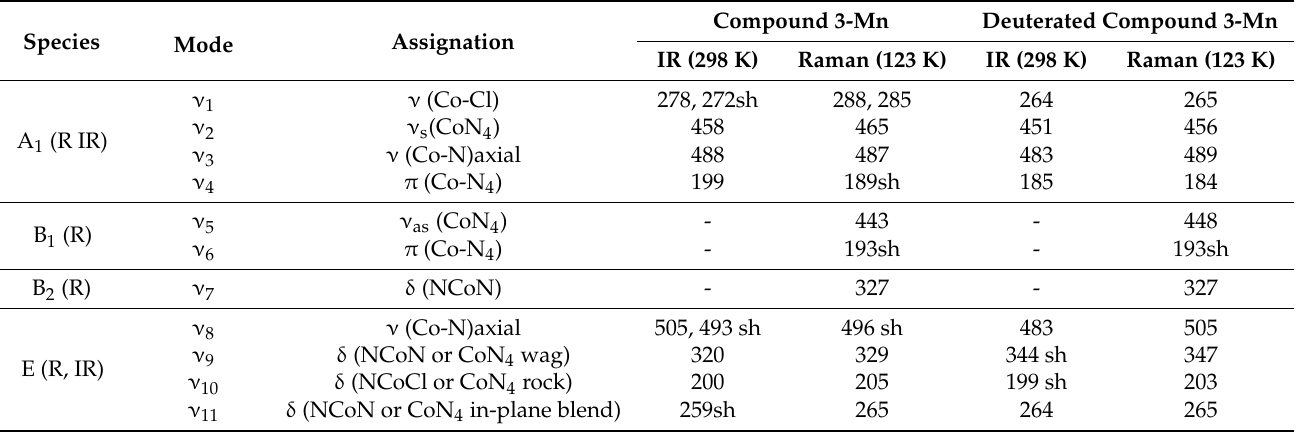
Table 5. Skeletal vibrational mode assignments in the IR and Raman spectra of compound 3-Mn and its deuterated